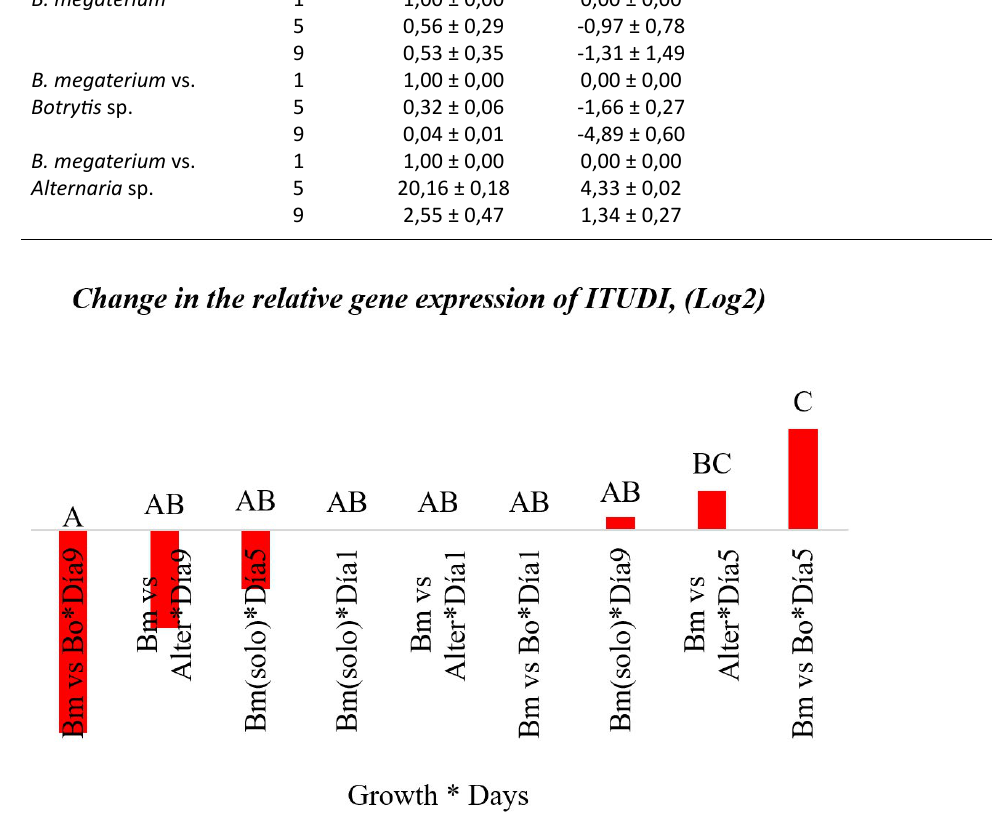
Fig. 3. Change in the expression of the ITUDI gene (logarithmic base scale